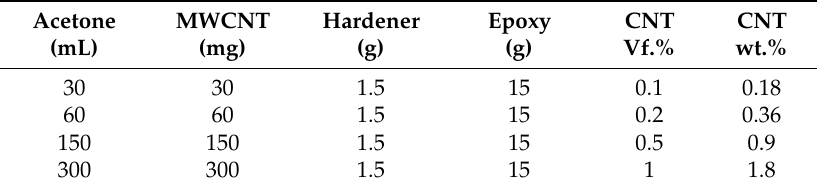
Table 3. Ratios of materials used for the production of nanocomposites with different volume fractions of multiwalled carbon nanotubes